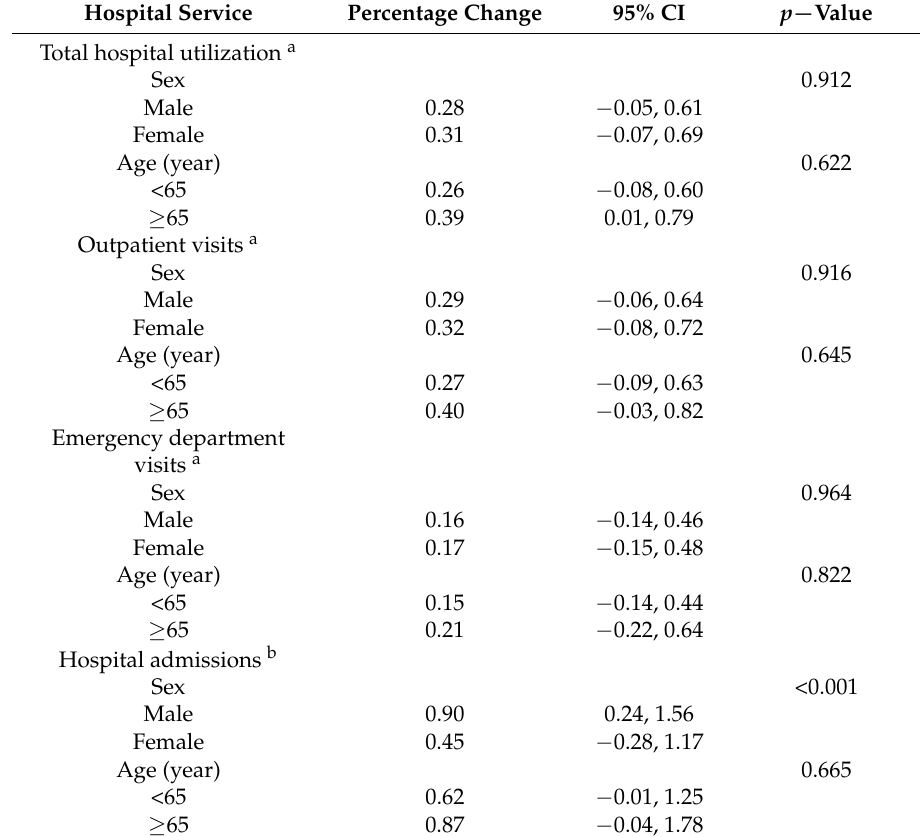
Table 4. The effect of a 10 µ g/m 3 increase in fine particulate matter (PM 2.5 ) concentration on URTI-related hospital utilizations by sex and